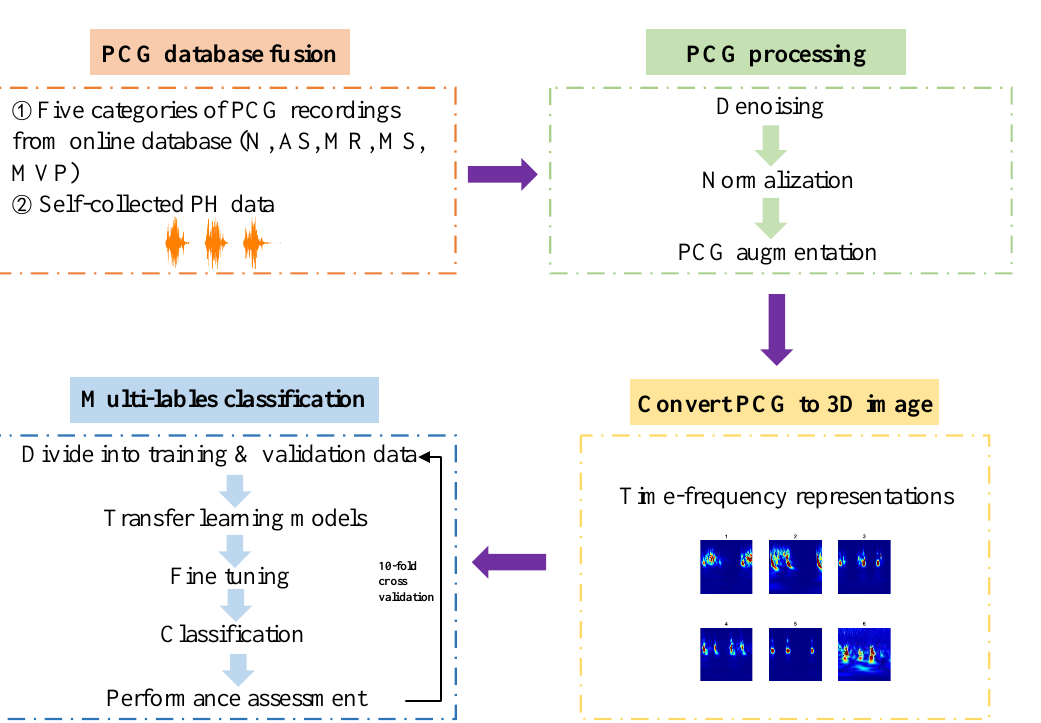
Figure 2. Flowchart of PCG classification by transfer learning models.